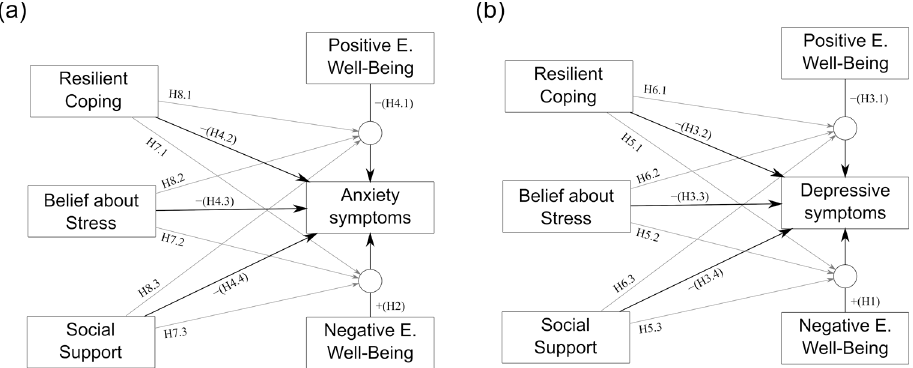
Figure 1. Model of proposed hypotheses for ( a ) anxiety and ( b ) depression.